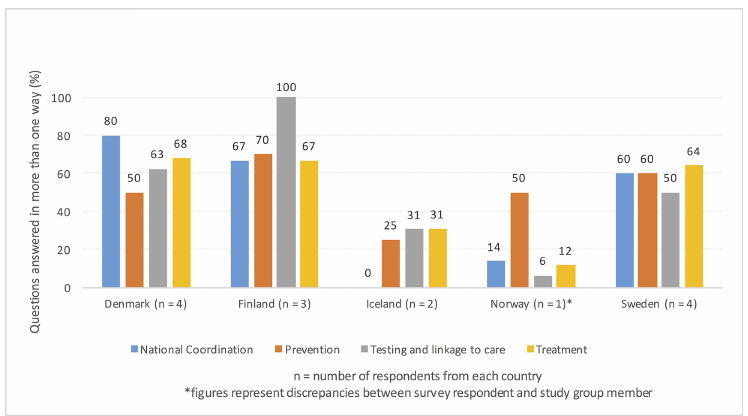
Fig 2. Incidence of stakeholder disagreement by country and survey